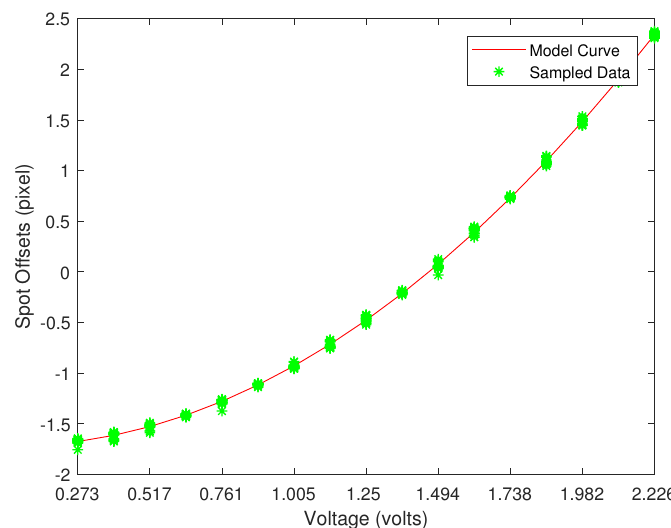
Figure 7. The fitting curve of the first electrode for the x coordinate of the 111st spot. Different from the modeling structure of the DM, the structure of FSM contains coupling terms depicting the collaborative effects of electrodes on spots offsets. This leads to the requirement that when modeling, the two electrodes should be modeled together. Therefore, the horizontal electrode is sequentially configured with a period of calibration voltages. Whenever the horizontal electrode is configured with a calibration voltage, the vertical electrode is configured with a period of calibration voltages in turn. Furthermore, due to the large maximum stroke of FSM, the used range of it is limited to ± 400 in digital voltages, as displayed in Figure